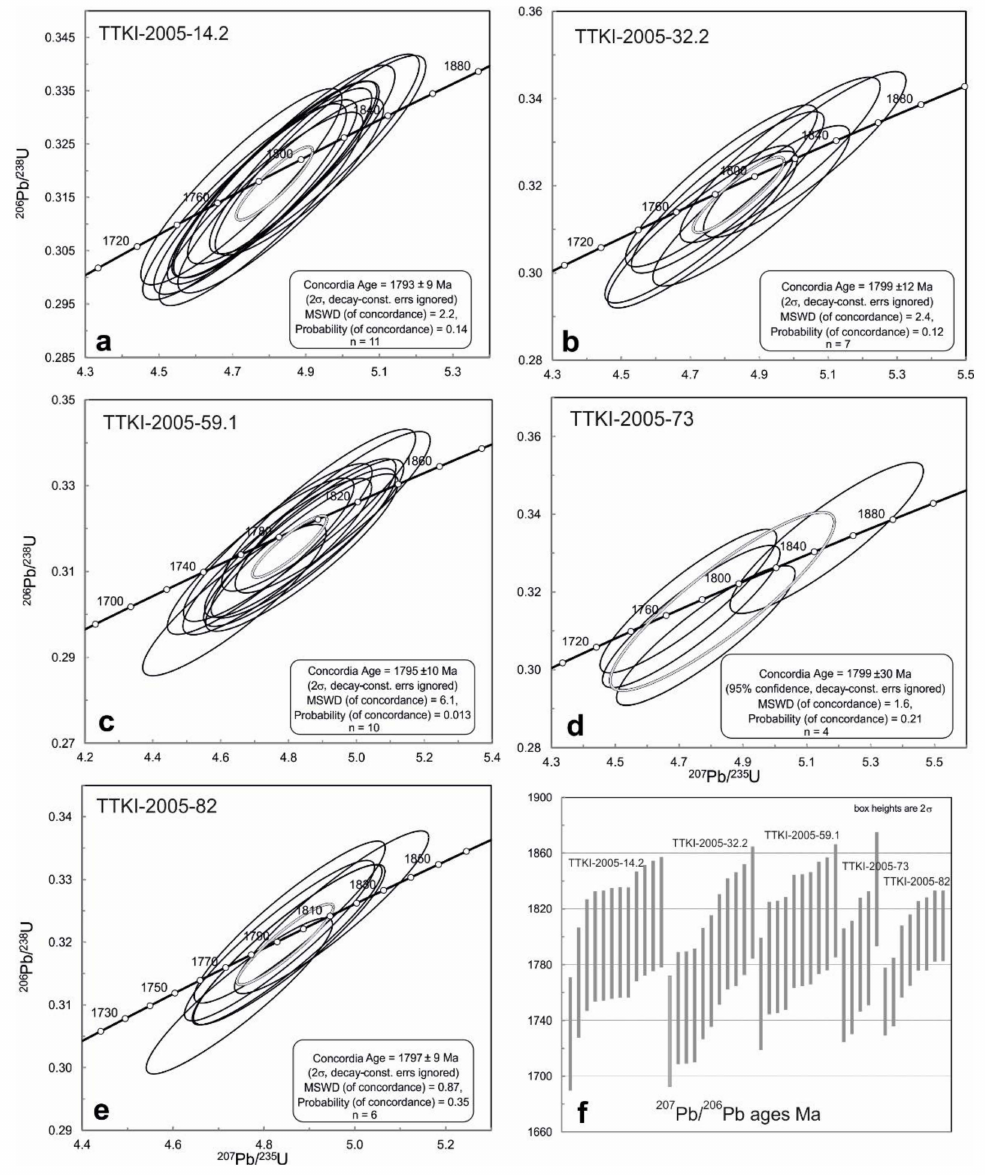
Figure 10. Concordia diagrams for monazite dated using the LA-ICP-MS ( a – e ) and the 207 Pb / 206 Pb ages of the analysis spots that were concordant within the 2 σ error ( f ). Data-point error ellipses are 2 σ